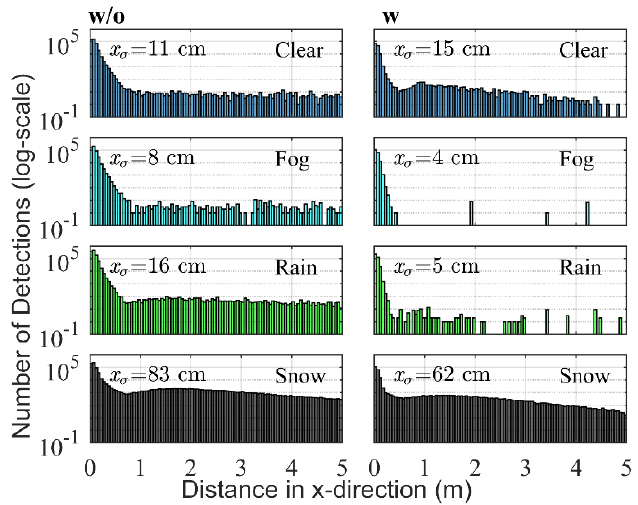
Figure 5. Distribution of the detections for each weather class (1900 frames each) in the atmosphere region (0-5 m) (w / o) without and (w) with background radiation. With x σ : standard deviation of the detection distance in x-direction in cm.